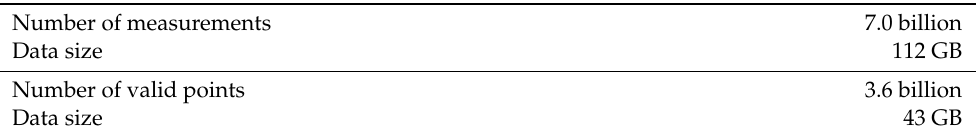
Table 3. Data size of Dataset